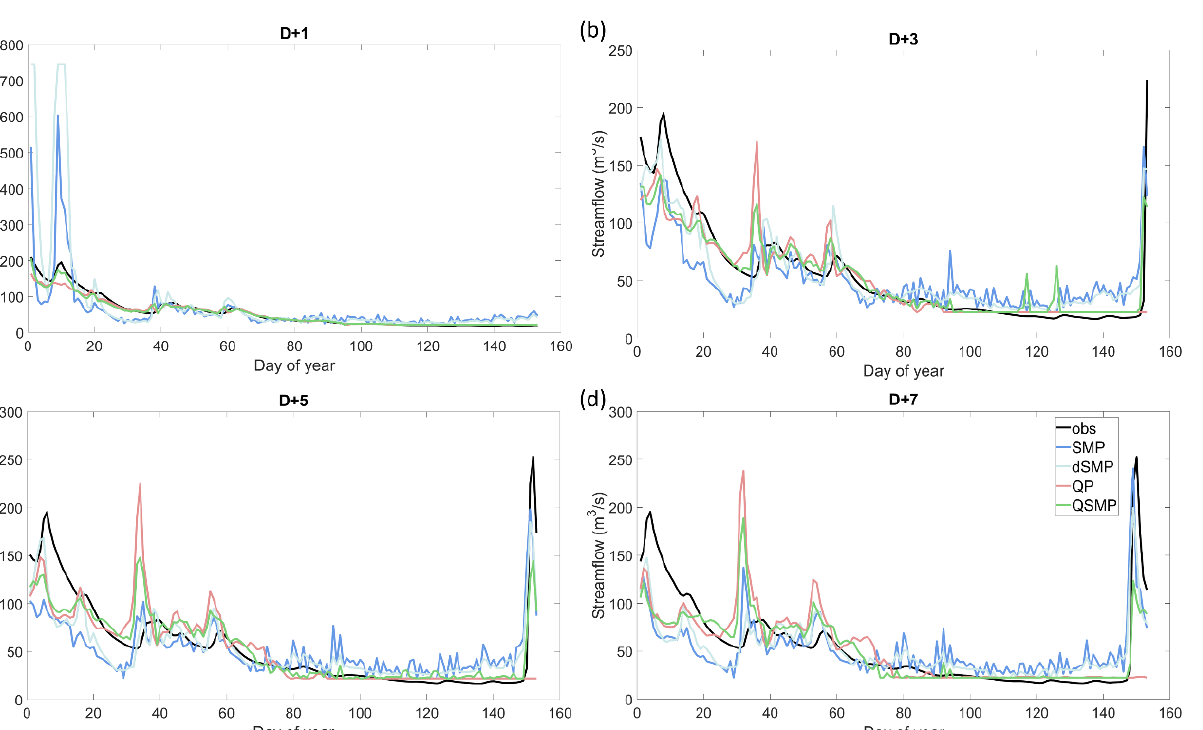
Figure 12. Hydrographs for the Susquehanna watershed for summer 2010 (validation period) ( a ) 1, ( b ) 3, ( c ) 5 and ( d ) 7 days in advance. 3.3. Spatial Discretization of Inputs Three main trends in model performance across the three spatial distribution ANN models were observed. First, the ANN model performance in training and validation was similar for both the global and fully distributed models, while the performance of single pixel-based models differed (Figure 13). We found that year-to-year dispersion, repre- sented by the difference between the 75th and 25th percentiles (i.e., the height of the box- plots), varied both across the forecast horizon and between the three spatial distributions (Figure 13). In training, dispersion was small for both the global and the fully distributed